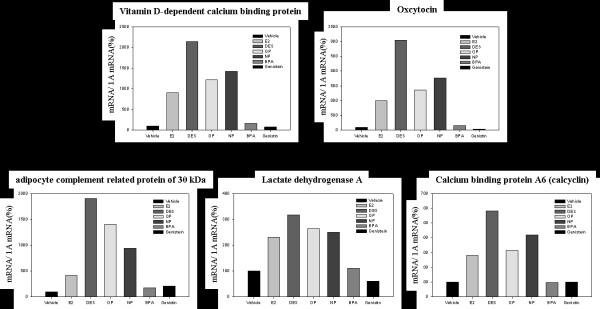
Confirmation of gene profiles by real-time PCR analysis. Relative values of expression of the altered genes quantified by real-time PCR are shown in graphs, indicating the comparison of fold change determined by real-time PCR analysis by E2, DES, OP, NP, BPA, and Gen in the uteri of immature rats. The representative genes are CaBP-9k, oxytocin, adipocyte complement related protein (MW 30 kDa), lactate dehydrogenase A and calcium binding protein A6 (calcyclin). Total RNAs from the uterus following treatment with estrogenic compounds were used to quantify altered gene expression normalized by cytochrome oxidase subunits I (1A) as a control.